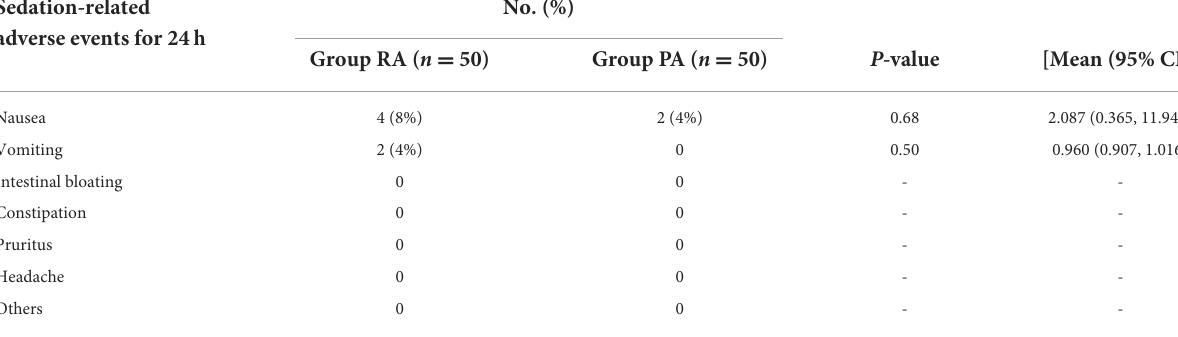
TABLE 6 Post-operative adverse effects were collected from the smartphone WeChat applet.